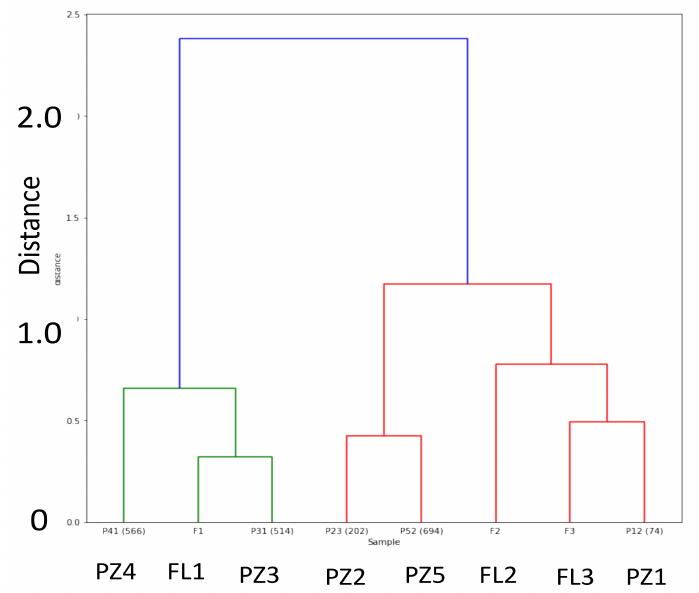
Figure 9. Hierarchical classification method—results with the flow rate and pressure